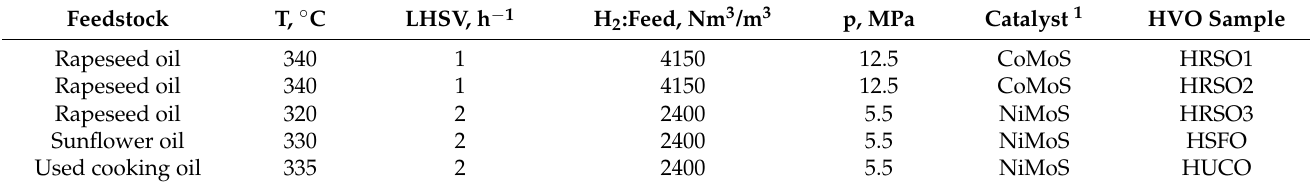
Table 2. Description of reaction conditions during HVOs